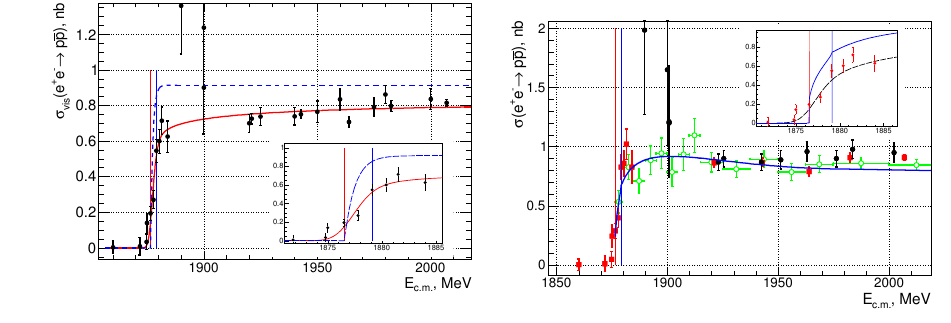
Figure 4. The e + e − → p ¯ p visible cross section measured with the CMD-3 detector. The solid curve shows the result of the fit to an exponen- tially saturated function of Eq.(3) (shown by the dashed curve) convolved with the 0.95 MeV en- ergy spread and radiation functions. The vertical lines show the p ¯ p and n ¯ n thresholds. The in- set shows the expanded view of the visible cross section.